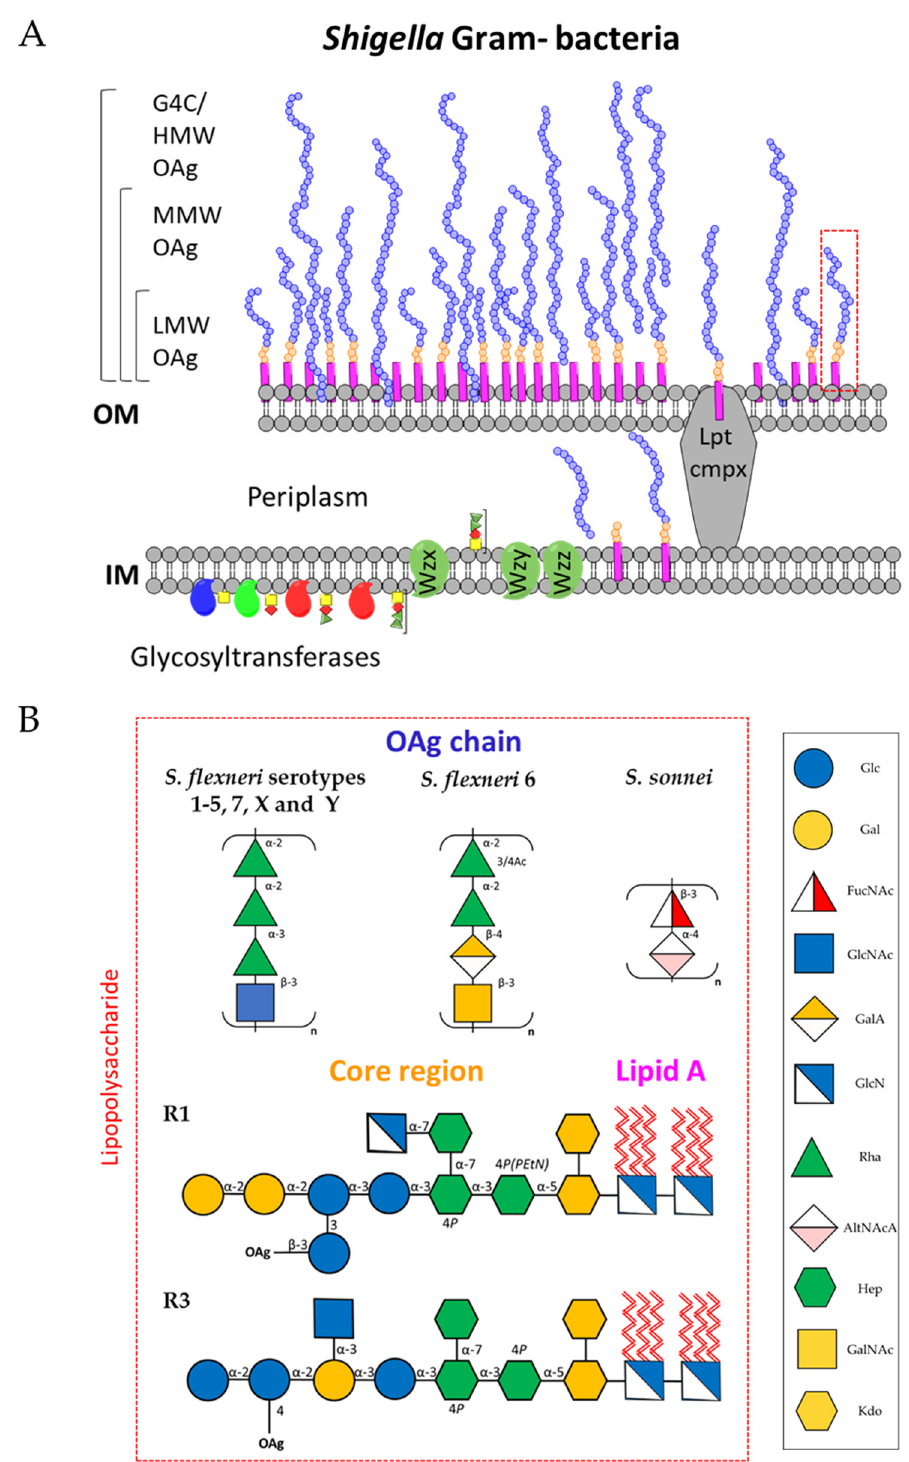
Figure 5. Biosynthesis of LPS moieties expressed on the membrane surface of Shigella bacteria ( A ). Structures of Shigella O-antigens and core regions ( B ). KDO: 3-deoxy- D -manno-2-octulosonic acid; Hep: L -glycero- D -manno-heptose; GlcN: glucosamine; GlcNAc: N-Acetylglucosamine; Rha: Rhamnose; GalA: galacturonic acid; GalNAc: N-Acetylgalactosamine; AltNAcA: N-Acetyl-amino altruronic acid; FucNAc: N-Acetyl- L -fucosamine; cmpx: complex; G4C: group 4 capsule; HMW: high molecular weight; MMW: medium molecular weight; LMW: low molecular weight.